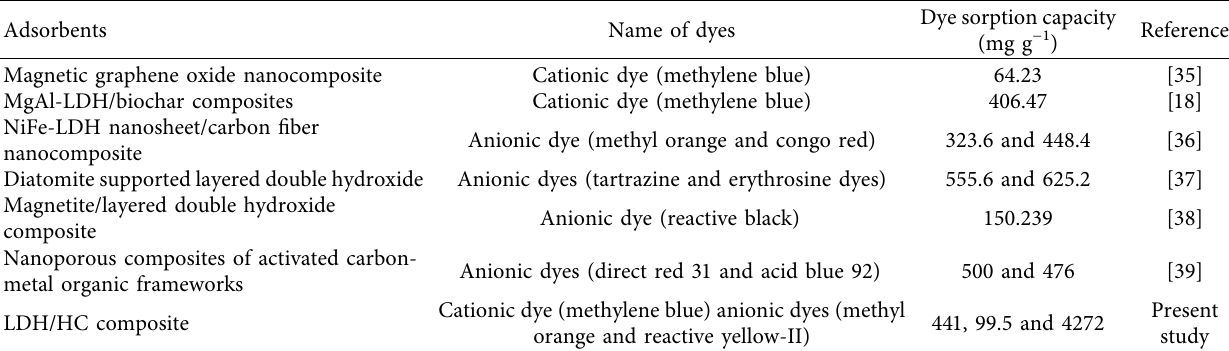
Table 7: Comparison of adsorption capacity with other LDH and HC